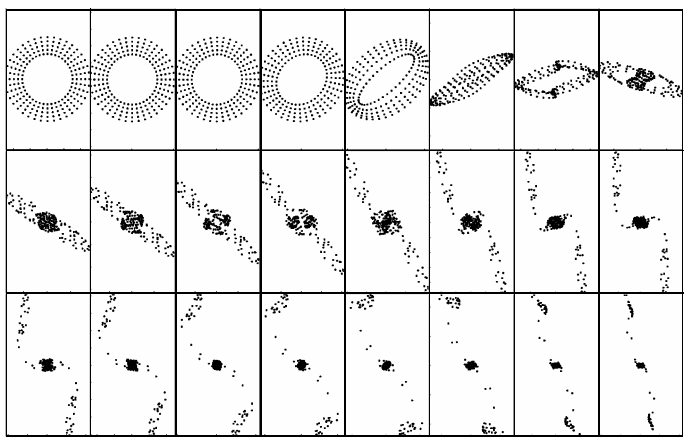
Fig. 3. Examples of regular orbits with initial conditions E = (cid:0) 1 : 2, h = (cid:0) 0 : 3, computed over the time interval (cid:28) = [0 ; 10]. The scale of the x -axis increases from [ (cid:0) 0 : 5; 0 : 5] (the top left panel) to [ (cid:0) 10 : 0; 10 : 0] (the bottom right panel), the scale of the y -axis increases from [ (cid:0) 1 : 0; 1 : 0] to [ (cid:0) 20 : 0; 20 :